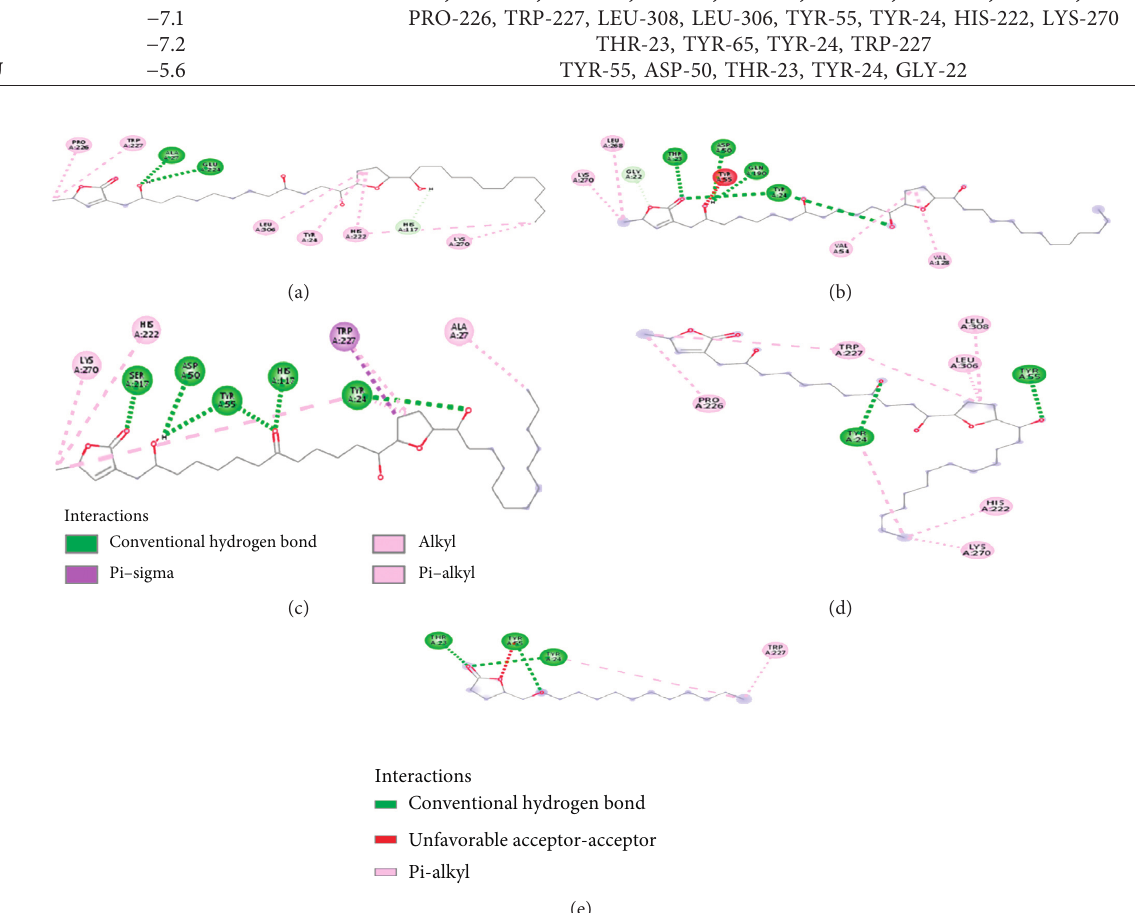
Figure 4: Binding interaction of compounds A , B , C , D, and E with 3 α -HSD,